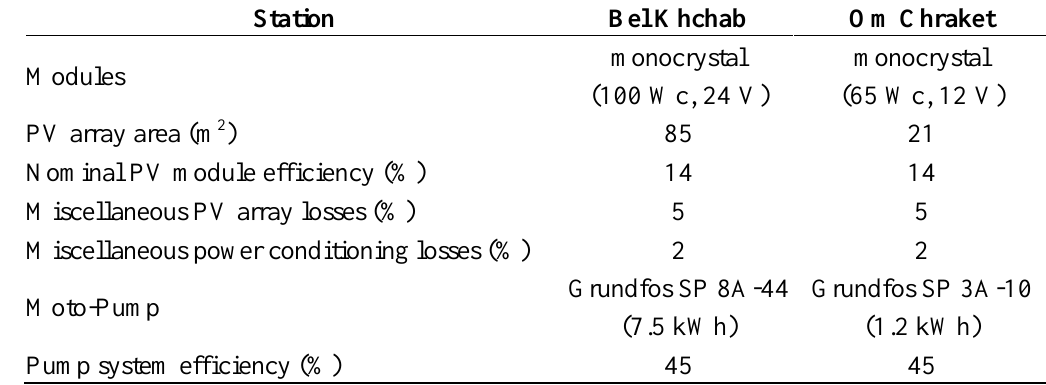
Table 2. Characteristics of the PV pumping